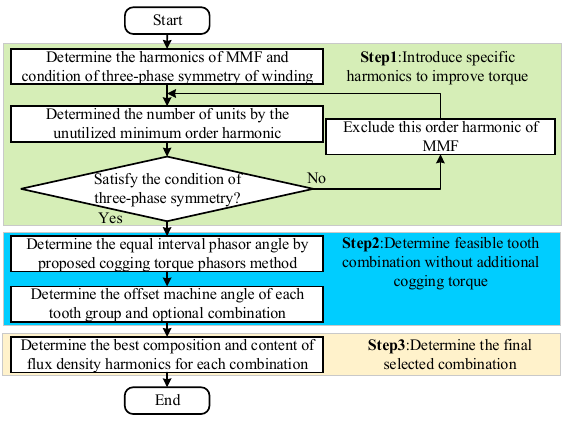
Figure 11. Design approach of non-uniform tooth distribution.